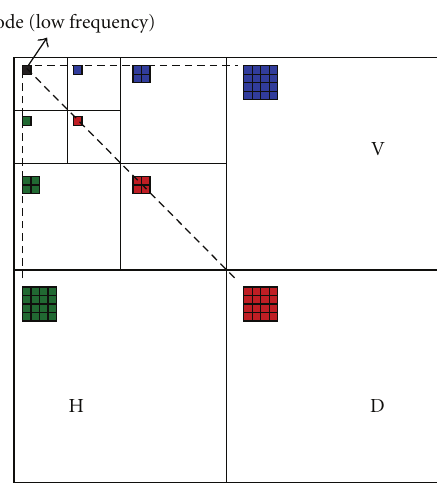
Figure 3: Wavelet decomposition of the 2D matrix and associated tree-based set originating from the low-frequency band. The root node (black) branches towards horizontal, vertical, and diagonal higher-frequency bands (H, V,